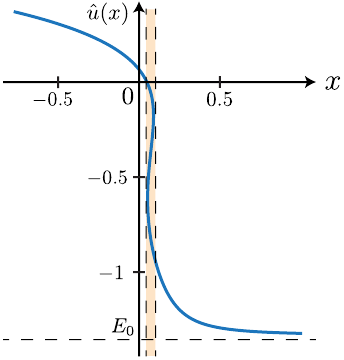
Figure 11. Numerical plots obtained by solving for the potential ˆ u ( x ) in (4.6) corresponding to the t’Hooft limit with q = 0 . 1 and λ = 0 . 038 > λ c = 0 . 035 . The asymptotic behavior of the solutions shows the distinct behavior at ˆ u (+ ∞ ) = E 0 . There is a shaded region for which ˆ u ( x ) is